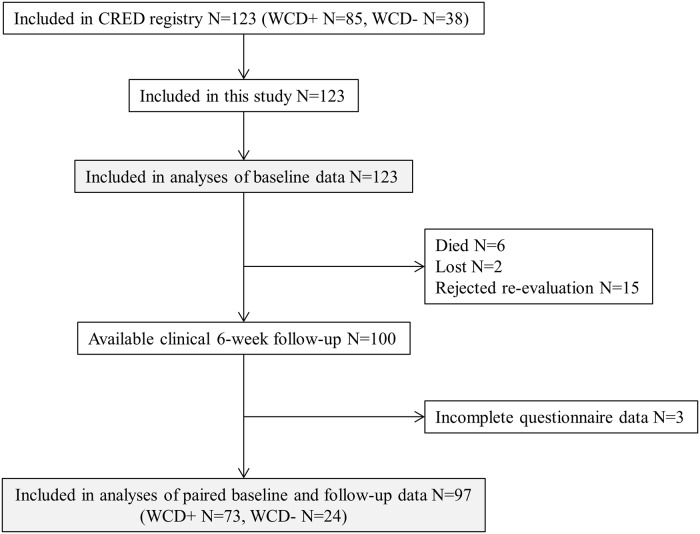
Flow chart of the study population.